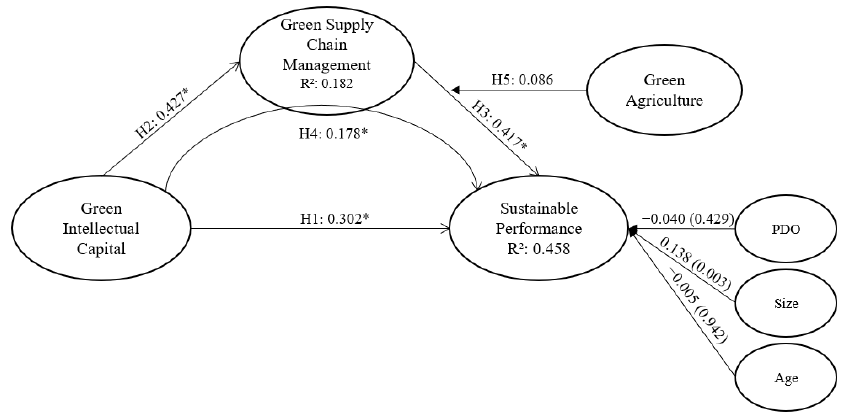
Figure 2. Theoretical model with R-squared, path coefficients ( β ) and significance. Source: Authors’ own elaboration. Note: * p < 0.001. Table 5. Results of the structural model for the mediation model.